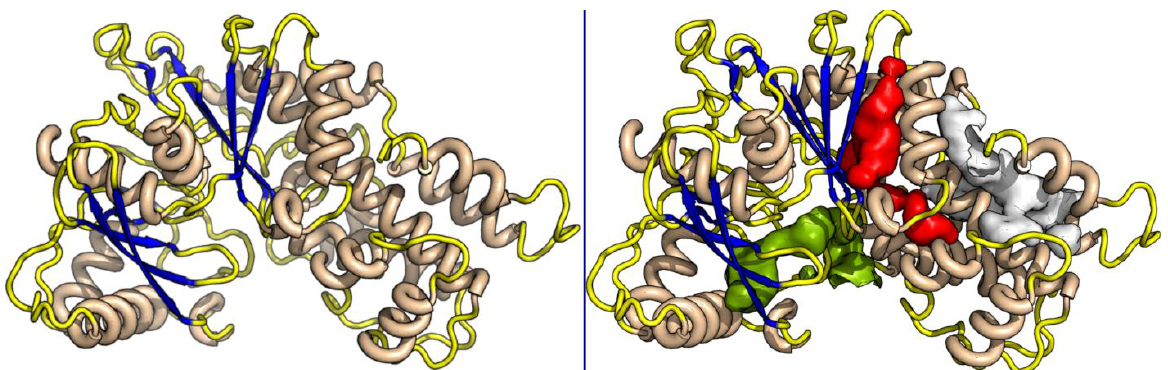
Figure 3. The 3D model of TbHK1 ( left ) and the most prominent pockets for ligand binding ( right ).